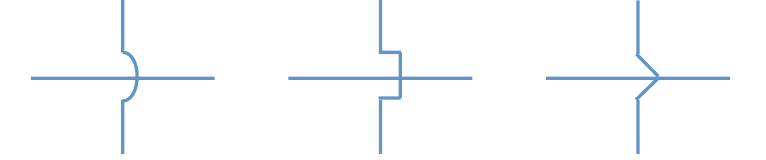
Figure 16: Examples of Interaction crossover patterns.